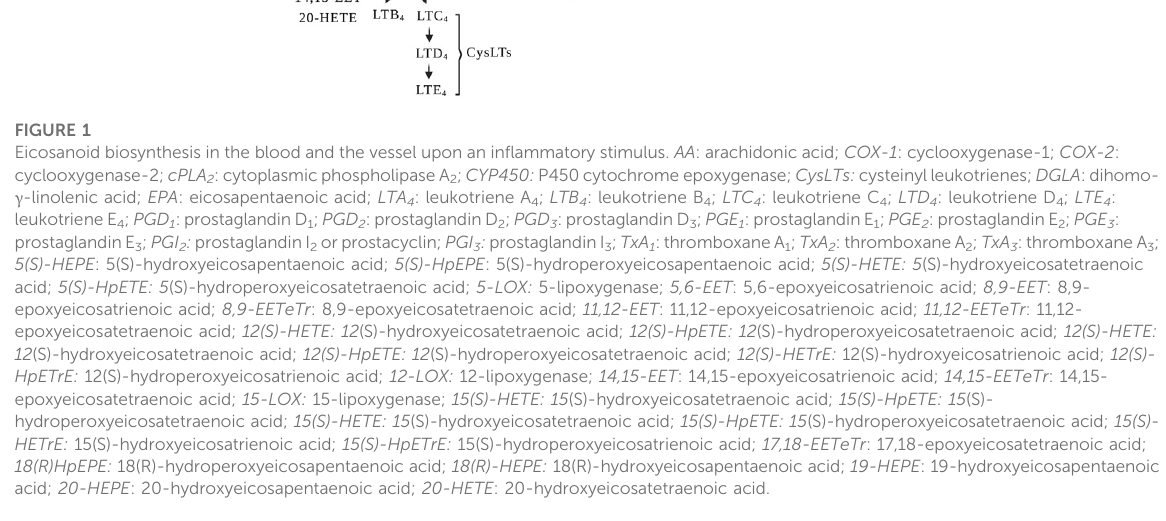
LTB 4 : leukotriene B LTC 4 : leukotriene C LTD 4 : leukotriene D LTE 4 : 4 ; 4 ; 4 ; 4 ;